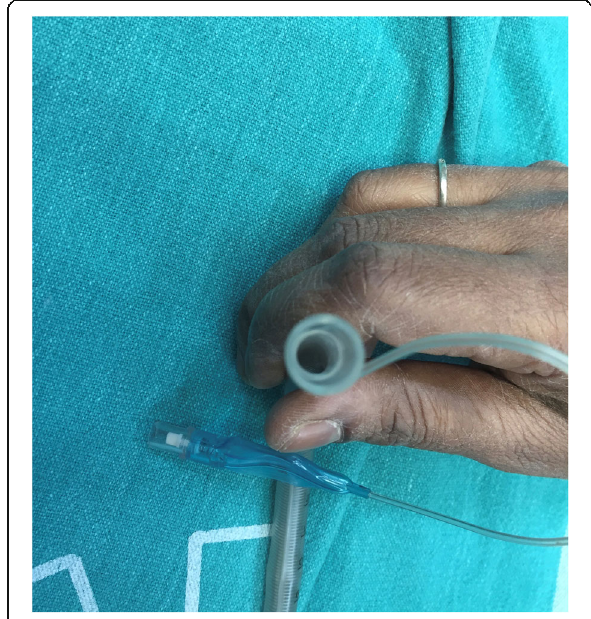
Fig. 1 A patent lumen of the armoured tube when the cuff is